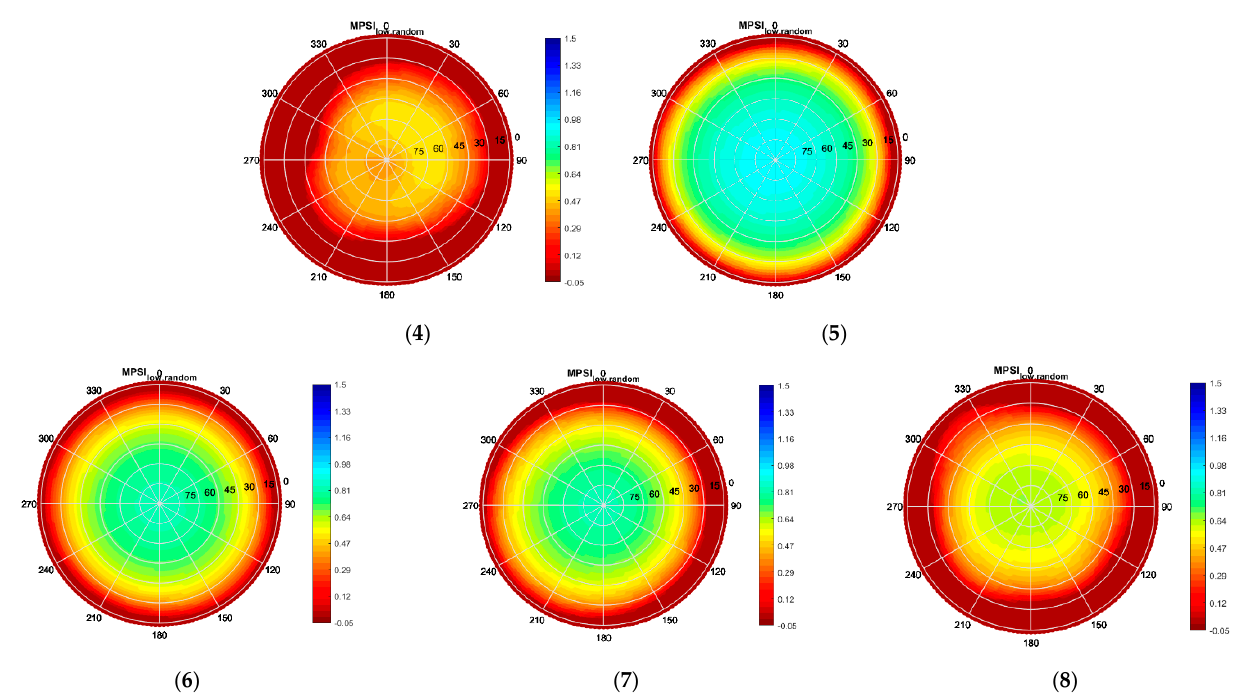
Figure A9. MPSI down at L1/E1 central frequency of the antennas measured at DLR; from left to right, from top to bottom: ( 1 ) Leica AR25 R4; ( 2 ) Novatel GNSS-750; ( 3 ) Javad RingAnt-DM; ( 4 ) Space Engineering GalExpAnt; ( 5 ) DLR internal design; ( 6 ) Novatel 703-GGG; ( 7 ) Navxperience Nav3G+C; ( 8 ) Tallysman VSE6028 VeroStar.